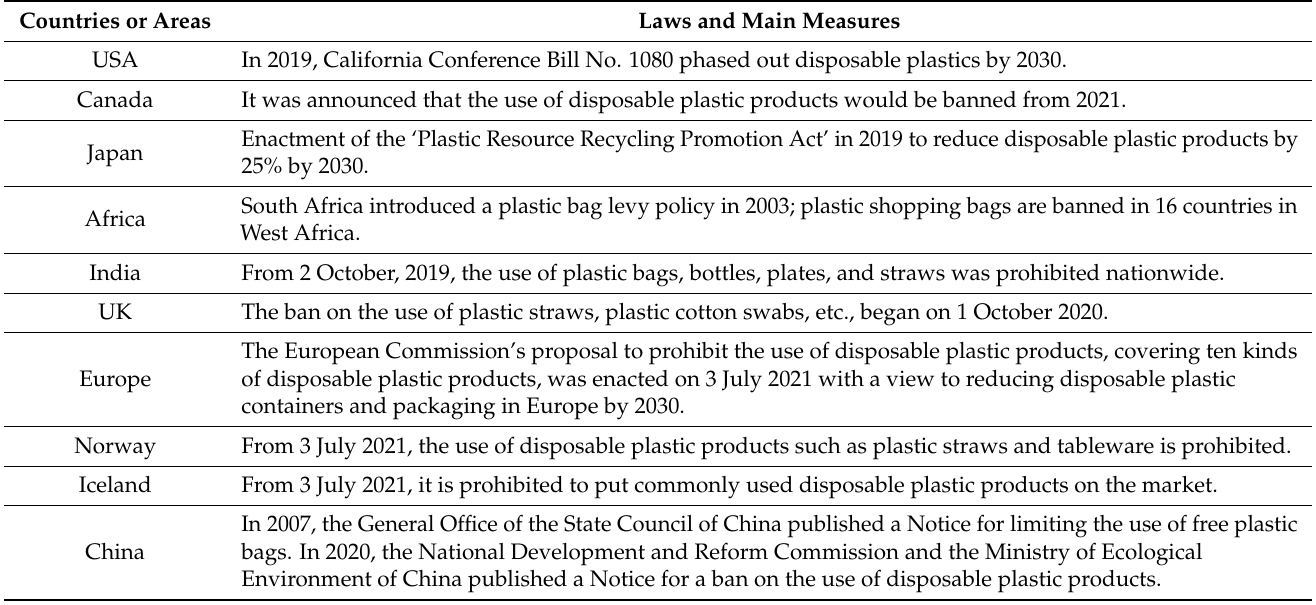
Table 1. Laws and main measures in different countries or areas